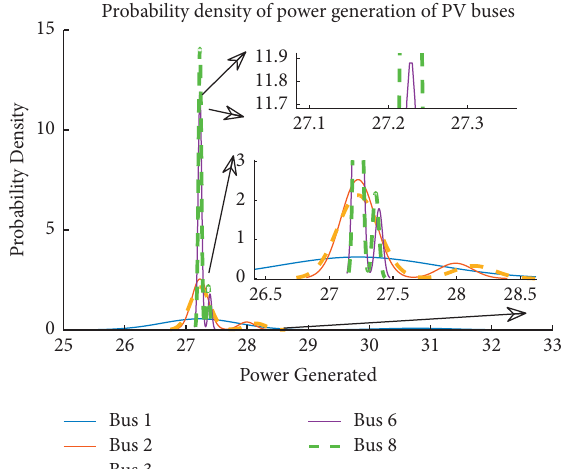
18: Cumulative power distribution at buses 1, 2, 3, 6, and 8.